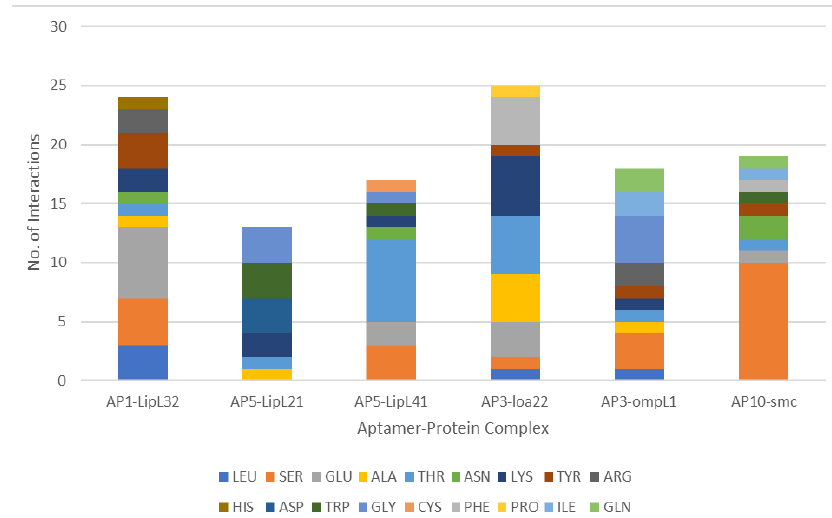
Figure 5. Number of interactions on the selected aptamer – protein model complexes.